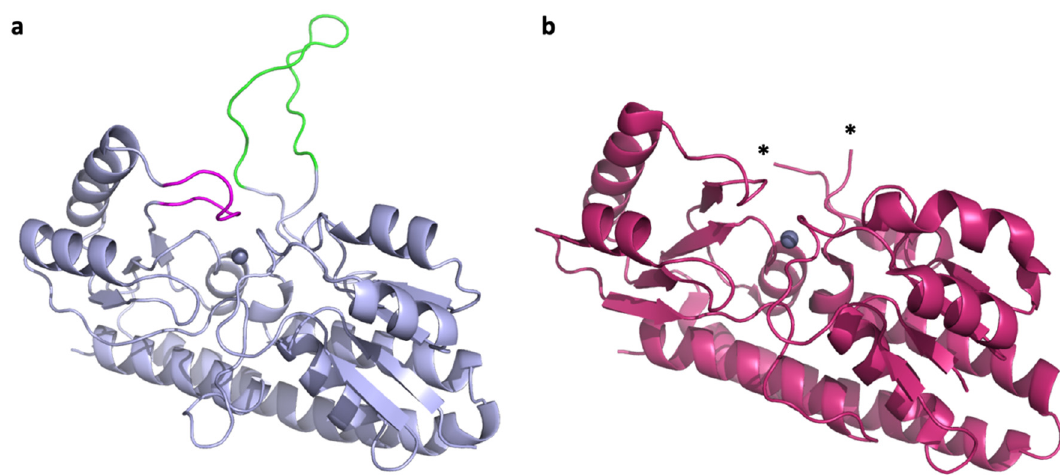
Figure 1. Zinc SBPs in P. denitrificans . ( a ) Crystal structure of P. denitrificans AztC (PDB ID: 5W57) [28] showing the D-Loop (green) and Z-Loop (magenta) structures. ( b ) Crystal structure of E. coli ZnuA (PDB ID: 2OSV) [29]. The D-Loop structure is not observed due to disorder and asterisks (*) mark the last modeled residues.